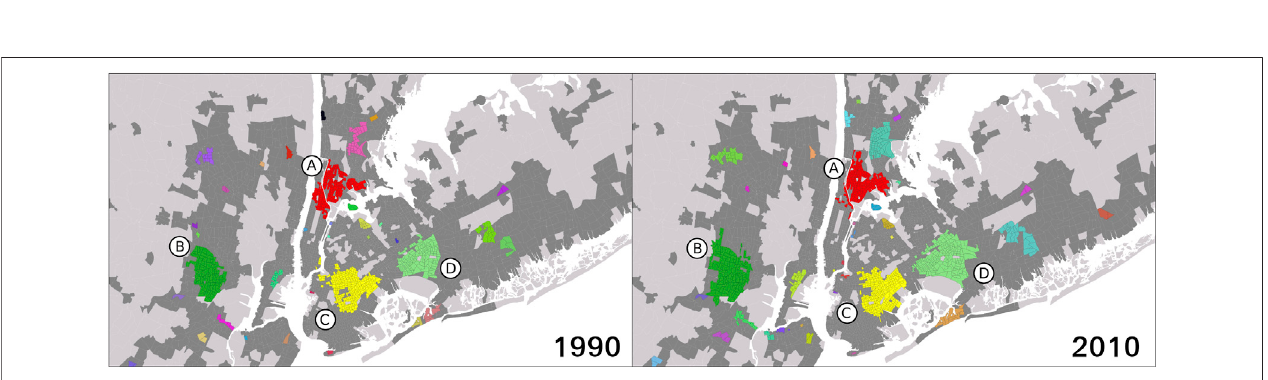
FIGURE 9 | Variation ofproperties values asa function of the fl ux of white and black citizens for the tractsthat change zone from 1990to 2010. (A) Variation of the propertiesvaluesasafunctionofthe fl uxofwhitecitizens.Thetractswithanoutgoing fl uxofwhiteareshowninorange,whilethetractswithanincoming fl uxofwhiteare shown in blue. The red square is the centroid of the outgoing fl ux, while the black circle is the centroid of the incoming fl ux. (B) Variation of the properties values as a function ofthe fl ux of black citizens. The tracts with an outgoing fl ux ofblack are shown asgreen squares, while the tracts with an incoming fl ux of black are shown as red circles. The red square is the centroid of the outgoing fl ux, while the black circle is the centroid of the incoming fl ux.